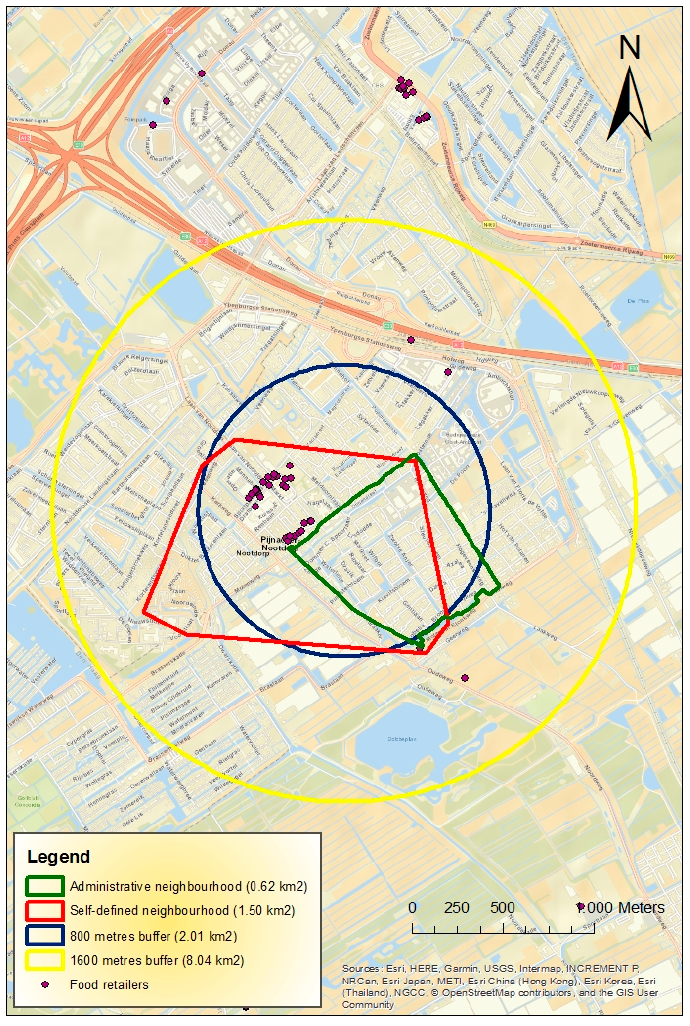
Figure 2. Example of the four neighborhood definitions and the food retailers